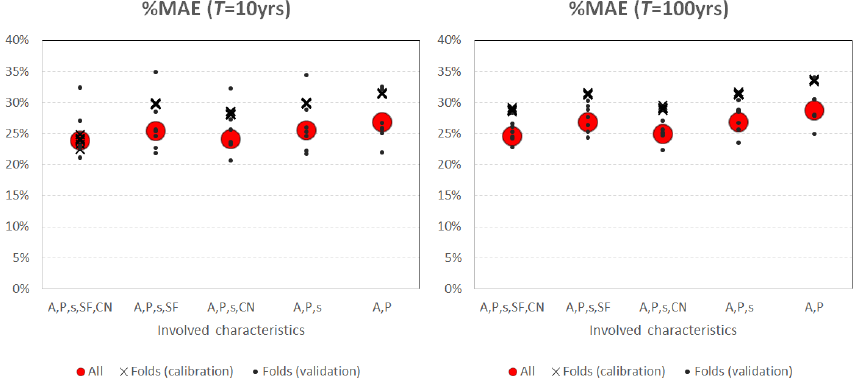
Figure 19. Values of relative mean absolute error for calibration to the whole data set and for calibration and validation using 7 folds for T = 10 years (left panel) and T = 100 years (right panel).